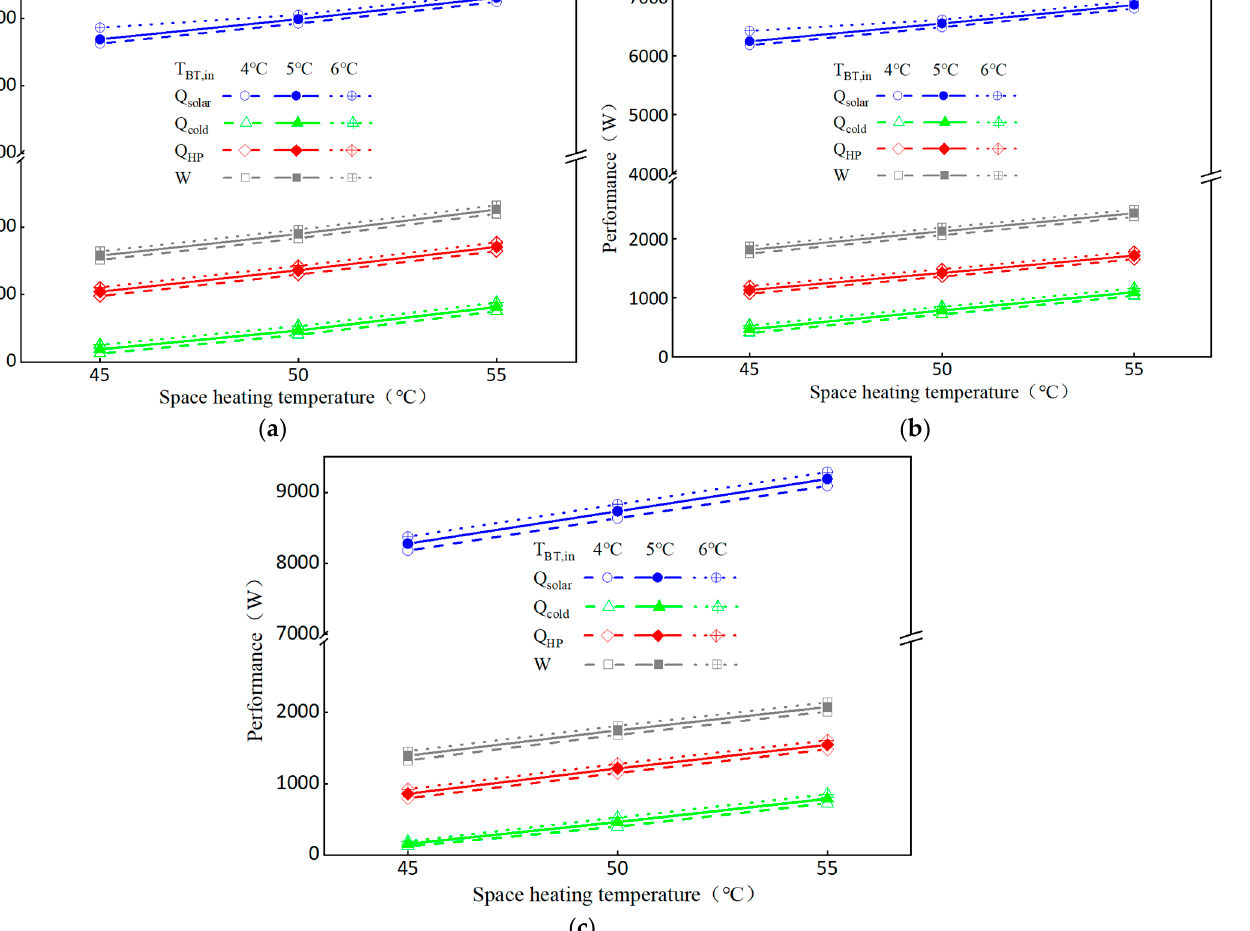
Figure 6. ( a ) Performance in mode 4 mode; ( b ) Performance in the mode 5 mode; ( c ) Performance in the mode 6 mode.